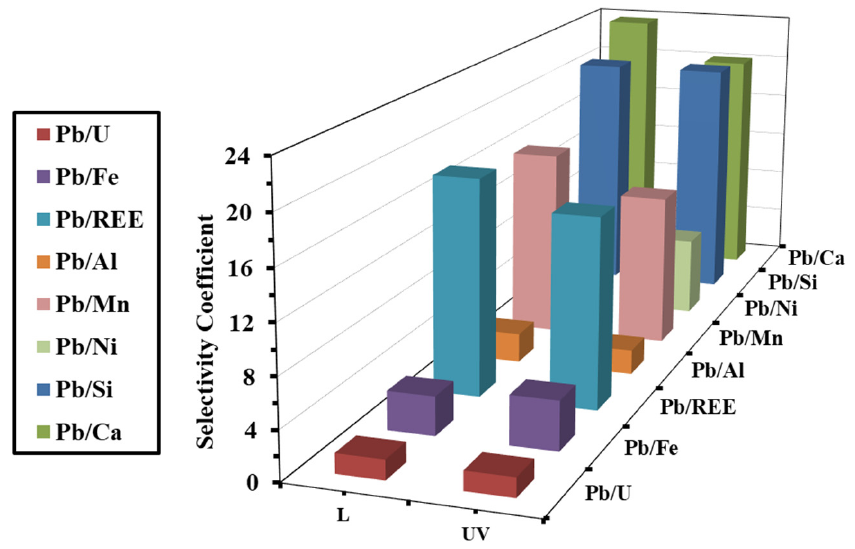
Figure 11. Selectivity coefficient of MCa-ATA under visible light (L) and UV conditions .